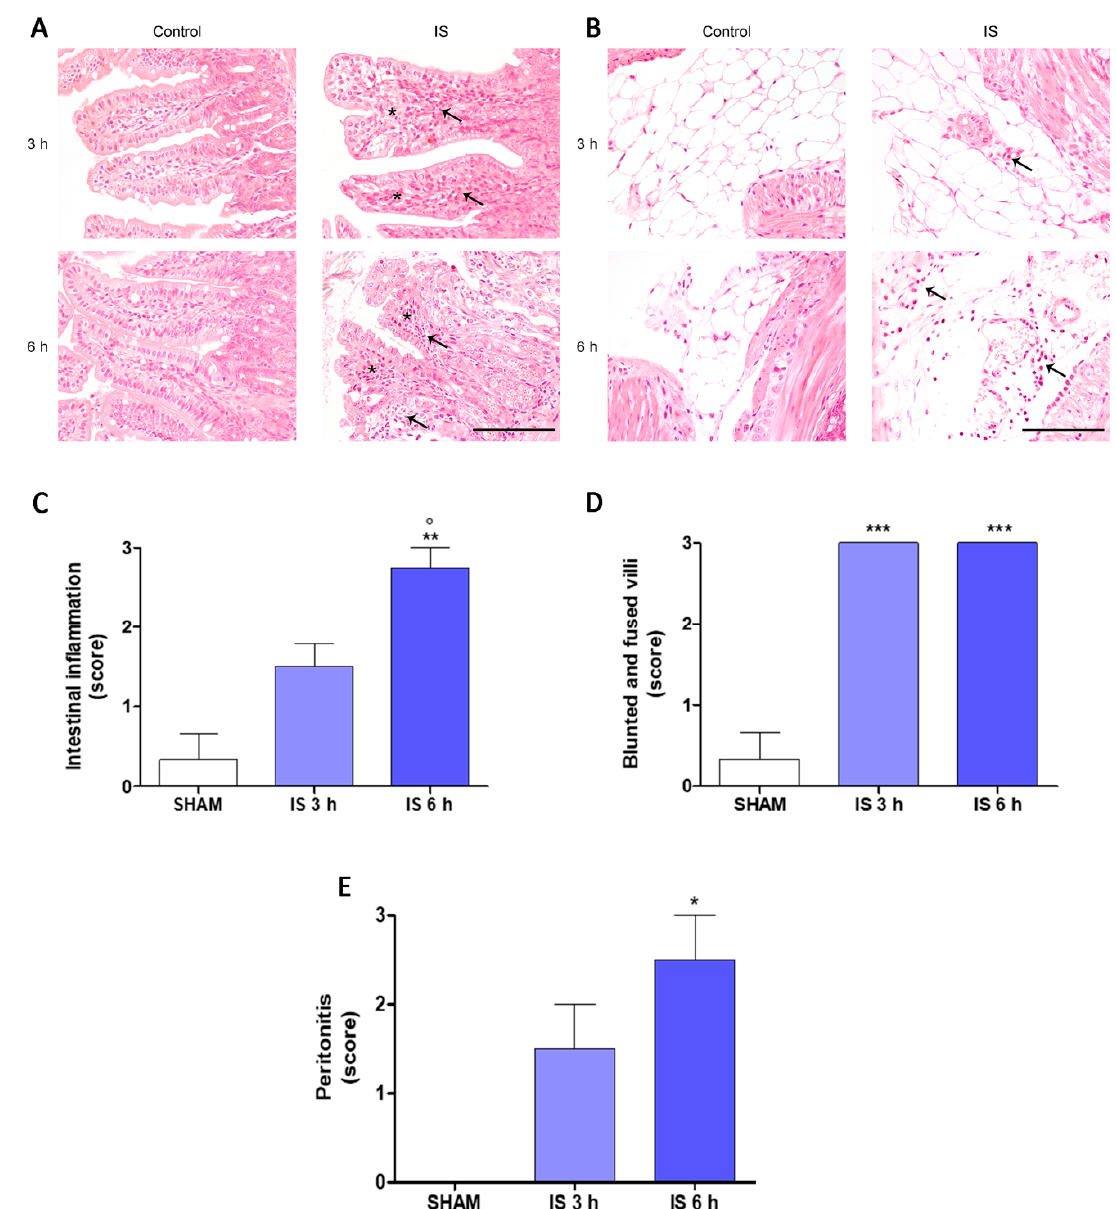
Figure 1. Histological examination of intestine ( A ) and mesenteries ( B ) of Indoxyl Sulfate (IS; 800 mg/kg; i.p.)-treated mice, after 3 h and 6 h from treatment (Hematoxylin and Eosin, 40× magnification, Scale Bar = 100 µm). ( A ) Mice treated with IS showed blunted and fused villi (asterisks) and infiltration of mononuclear inflammatory cells in the lamina propria (arrow) both 3 and 6 h after treatment. ( B ) The mesenteries of mice treated with IS were infiltrated by inflammatory cells (arrow) both 3 and 6 h after treatment. Score of intestinal inflammation ( C ), blunted and fused villi ( D ), and peritonitis ( E ). ***, ** and * denote respectively p < 0.001, p < 0.01 and p < 0.05 vs. SHAM; ° denotes p < 0.05 vs. IS 3 h.